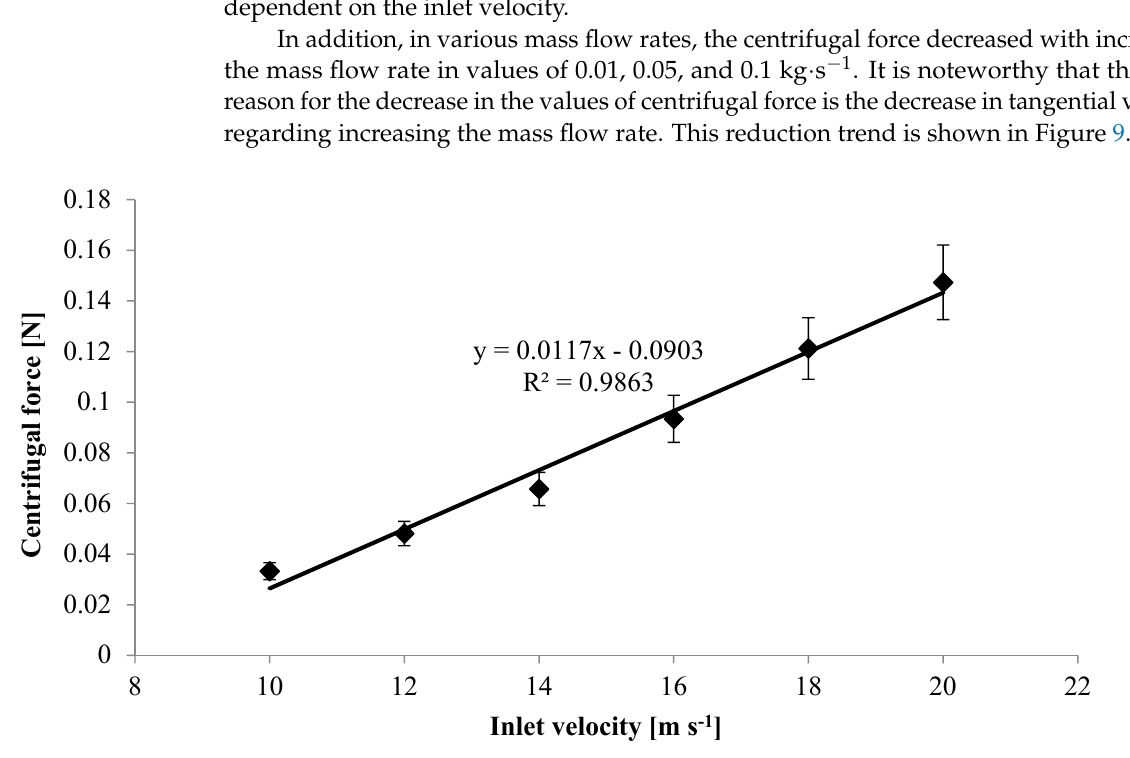
Figure 8. Centrifugal force acting on a particle in various inlet velocities with error bars of 10%.